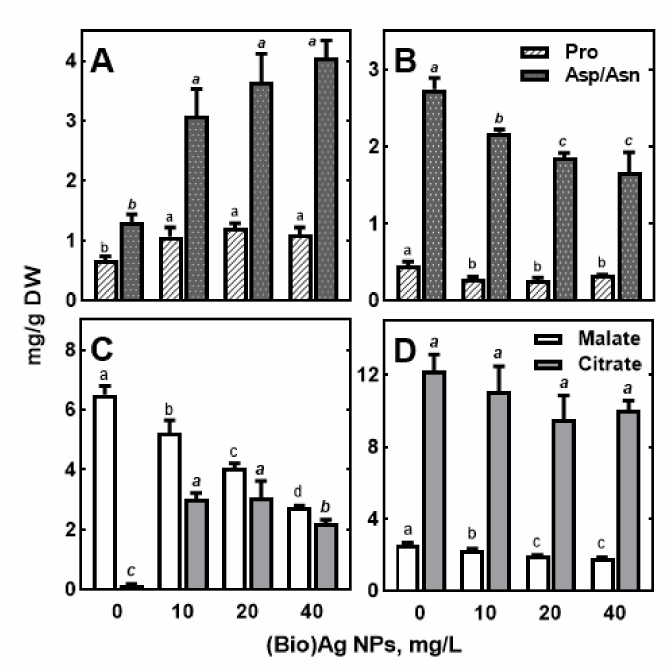
Figure 9. The effect of (Bio)Ag NPs on the content of proline (Pro), aspartate/asparagine (Asp/Asn), malate, and citrate in roots ( A , C ) and coleoptile ( B , D ) of 3-days-old seedling of wheat ( Triticum aestivum L. cv ‘Ostka Strzelecka’). Control grains germinated in dd. water. Values are means ( n = 3) ± SD. Bars with the same letters (a–c, a–c ) are not significantly ( p < 0.05) different after the ANOVA test and Tukey’s post hoc